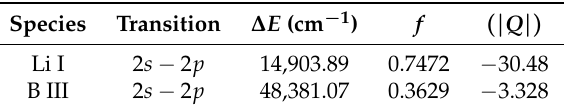
Table 1. Atomic data used for the calculations: transition energies ∆ E , absorption oscillator strengths f , and the reduced quadupole matrix elements ( | Q | )